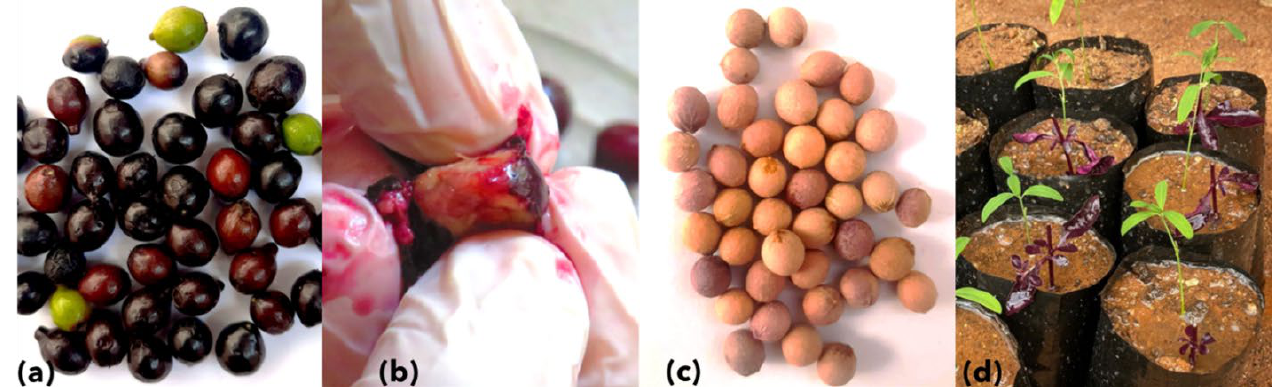
Figure 1. Sandalwood seed germination and seedlings generation. Collection of healthy drupe fruits ( a ), de-pulping of individual fruit ( b ), clean and dried seeds ready for sowing ( c ), and asymptomatic sandalwood seedlings at 25–35 DAS grown along with host plant Alternanthera sp. (Amaranthaceae). The host plant can be seen in deep purple color ( d ).